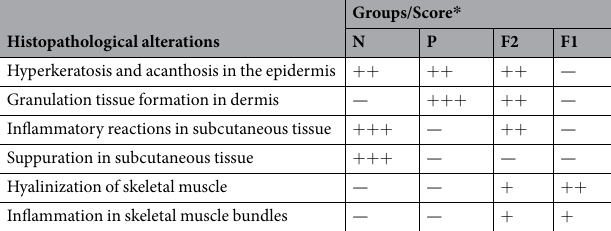
Groups/Score * N P F2